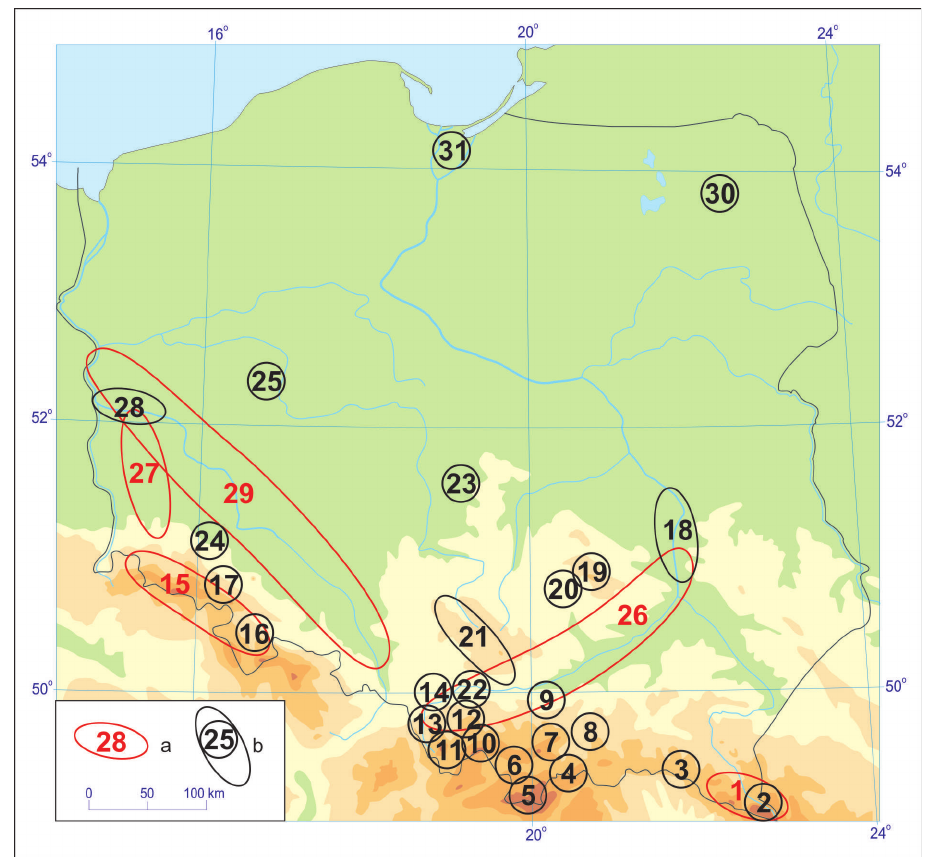
Figure 2. Regions of Poland studied by various authors: 1 Beskid Wschodni Mts. 2 Bieszczady Mts. 3 Beskid Niski Mts. 4 Pieniny Mts. 5 Tatra Mts. 6 Orava-Podhale Depression 7 Gorce Mts. 8 Beskid Wyspowy Mts. 9 Wieliczka Foothill 10 Range of Babia Góra 11 Beskid Żywiecki Mts. 12 Beskid Mały Mts. 13 Beskid Śląski Mts. 14 Silesian Foothill 15 Sudety Mts. 16 Kłodzko Basin 17 Wałbrzych Mts. 18 Małopolska Gap of the Vistula 19 Świętokrzyskie Mts. 20 Jędrzejów Plateau 21 Kraków- Częstochowa Upland 22 Oświęcim Basin 23 Łask Upland 24 Legnica Plain 25 Poznań Lakeland 26 Vistula catchment up to Kazimierz Dolny town 27 Bóbr River catchment 28 Central Oder Valley 29 Oder catchment up to the outlet of the Warta River 30 Ełk Lakeland 31 Vistula Fen Country. a area of species occurrence without exact localization given b geographical regions with detailed localization of species